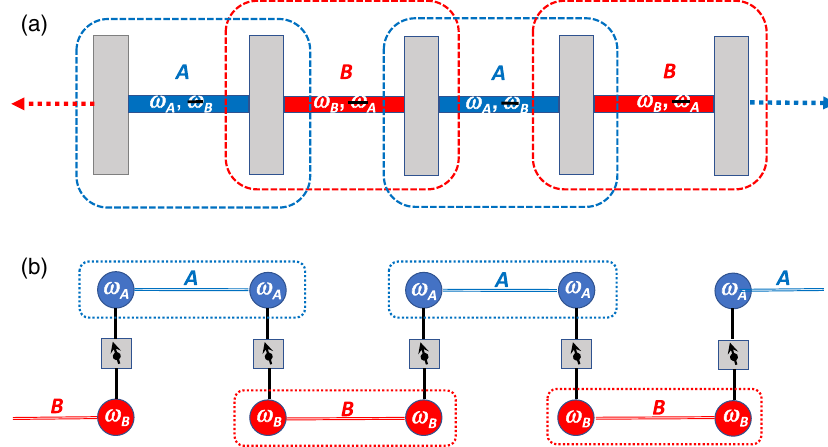
FIG. 1. (a) Schematic of a quantum network with alternating waveguides. Each mechanical resonator (the rectangular plate) couples to two different phononic waveguides, A and B . Propagation near frequencies ω forbidden for waveguides A and B , respectively. (b) In each resonator, a spin system couples selectively to two resonator modes with frequency ω and ω . As indicated by the dashed-line boxes, any two neighboring resonators and the waveguide between them can form A B a closed mechanical subsystem. The network thus consists of closed mechanical subsystems coupled together via the